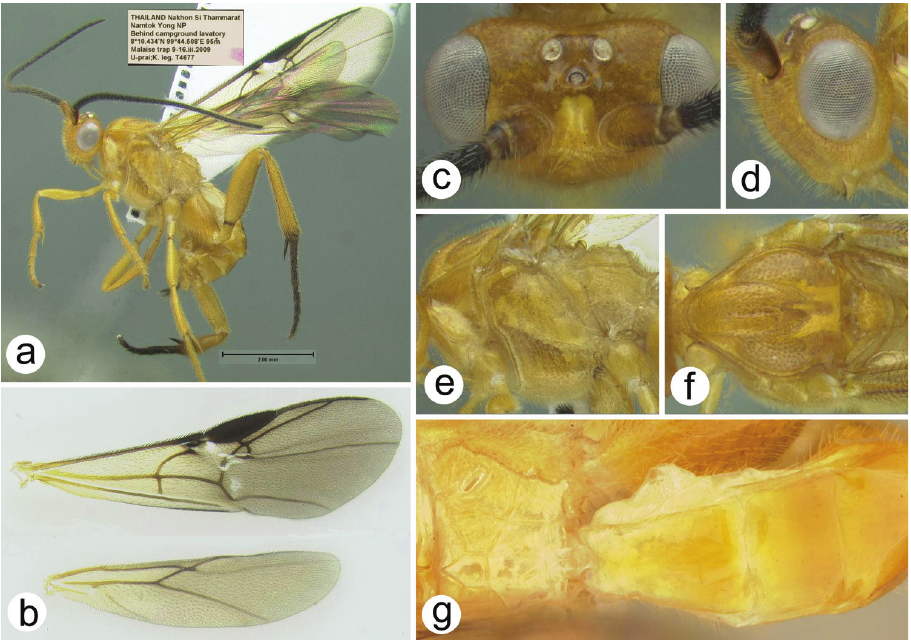
Figure 9. Zelodia nikomi sp.n. a lateral habitus b wings c dorsal head d lateral head e lateral mesosoma f dorsal mesosoma g dorsal propodeum and Zelodia nopadoli Sharkey sp.n. urn:lsid:zoobank.org:act:CDC346AF-61D7-4CA3-88A6-33318DA2939E http://species-id.net/wiki/Zelodia_nopadoli Fig. 10 Diagnosis. Mesoscutum entirely melanic; head, except antenna, pale. Description. Body length 7.7 mm (6.2–7.7). Head. (37–41) flagellomeres (both flagella broken in holotype). Median ocellus diameter equal to the space between lateral ocelli. Vertex sparsely and weakly punctate. Mesosoma. Notauli mostly or entirely crenulate. Metapleuron with moderately dense setae. Fore wing cells hyaline basally, infuscate distally, veins including stigma melanic. Hind tarsal claw bifid. Length/width of hind femur 2.059/0.551 = 3.8 (3.5–4.8). Lateral surface of hind femur aciculate. Metasoma. Length/width ratio of MT1, 1.231/0.583 = 2.1 (2.1–2.3). Ratio of widest point of MT1 to narrowest point 0.583/0.376 = 1.6 (1.2–1.6). Color. Mostly black with yellow, white and cream color; head yellow, scape brown, flagellum black, prothorax yellow; fore leg and mid leg, except parts of coxa, yellow; MT1 and MT2 cream colored; basal laterotergites and sterna white; remainder of body black.